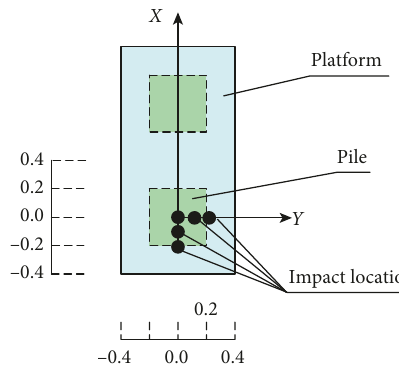
Figure 3: Impact locations of the two-pile